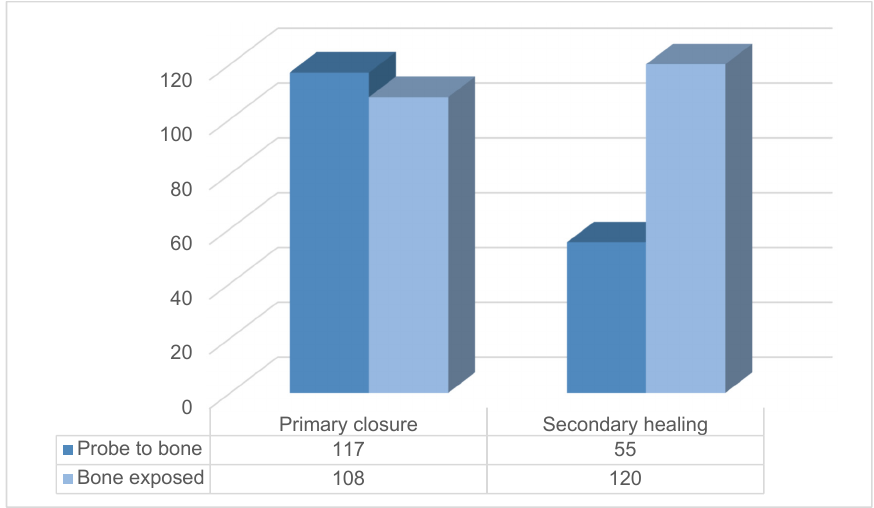
Figure 2. Distribution of bisphosphonates by administration route.